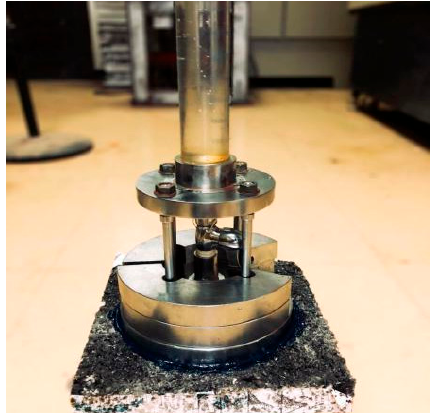
Figure 9. Device of water seepage test.